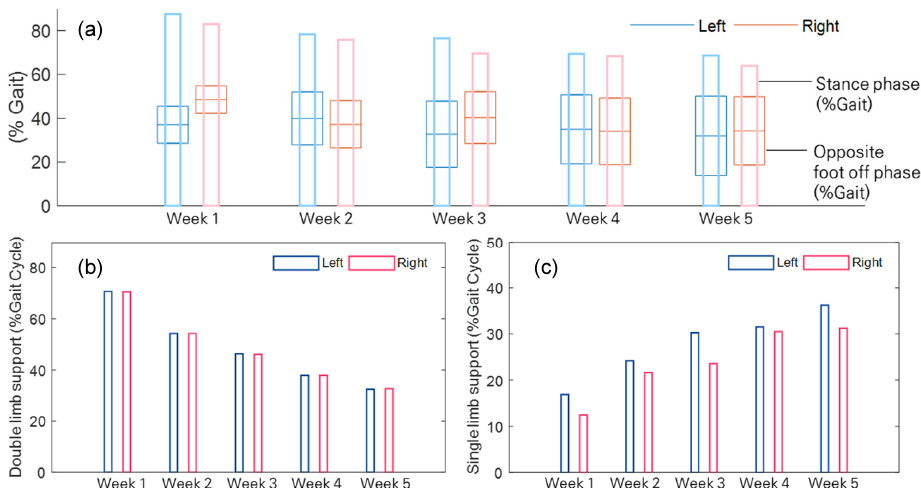
Figure 16. Results of five-week walking training with Angel Legs and using bilateral crutches. ( a ) Percentage of stance phase and single limb support (opposite foot-off) time of left and right legs. ( b ) Percentage of double limb support time during a gait. ( c ) Percentage of single limb support time during a gait.